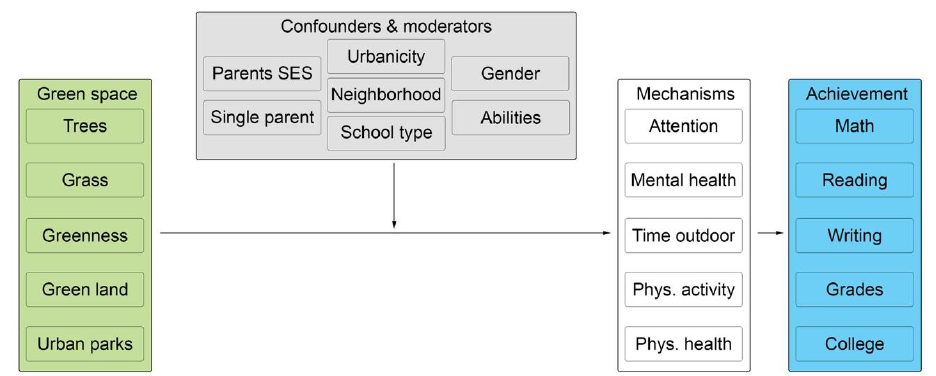
Figure 3. Conceptual framework adapted from the model proposed by Markevych and colleagues linking green space near schools to academic performance [51].